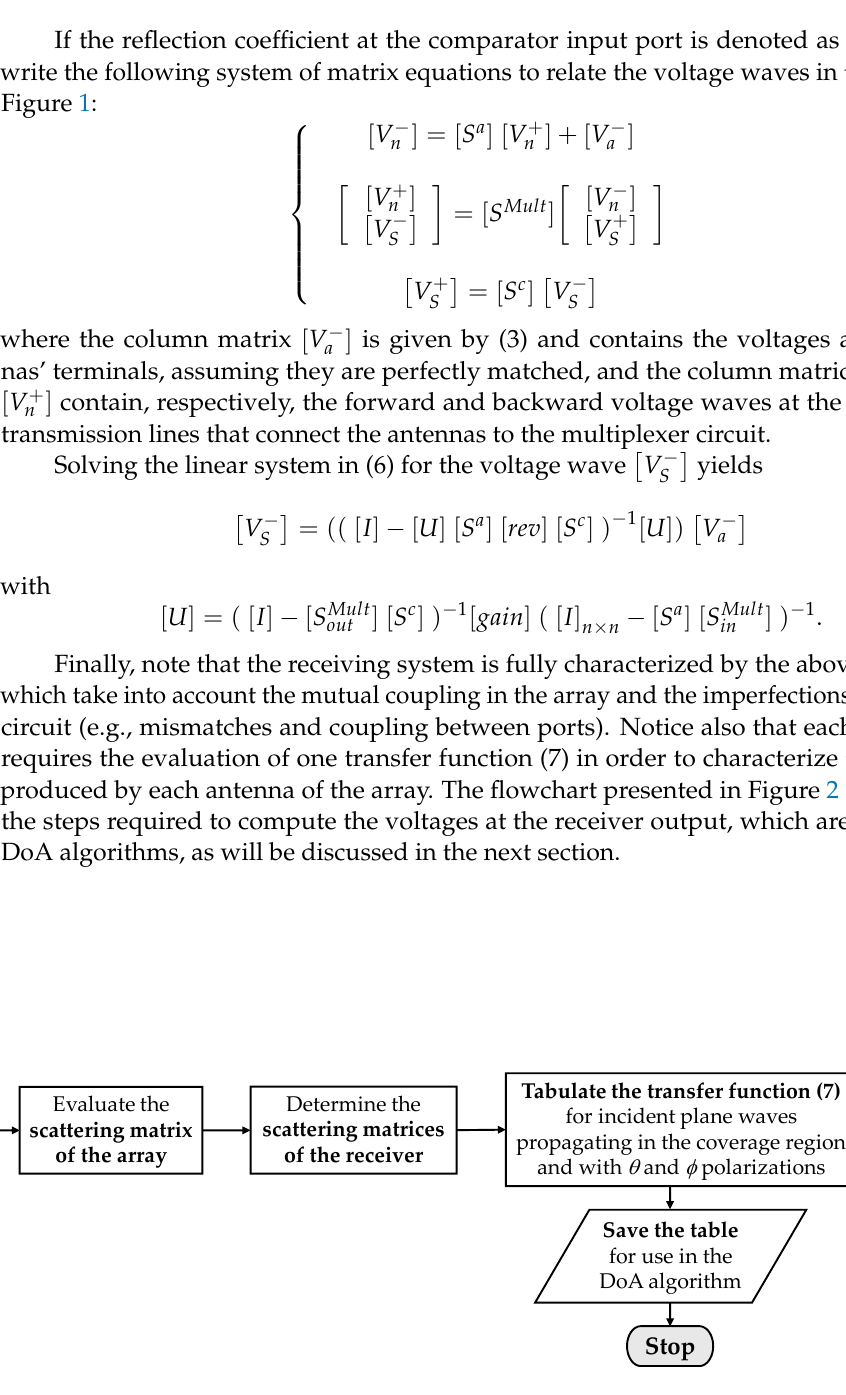
Figure 2. Flowchart of the formulation to compute the voltages used in the DoA algorithms.